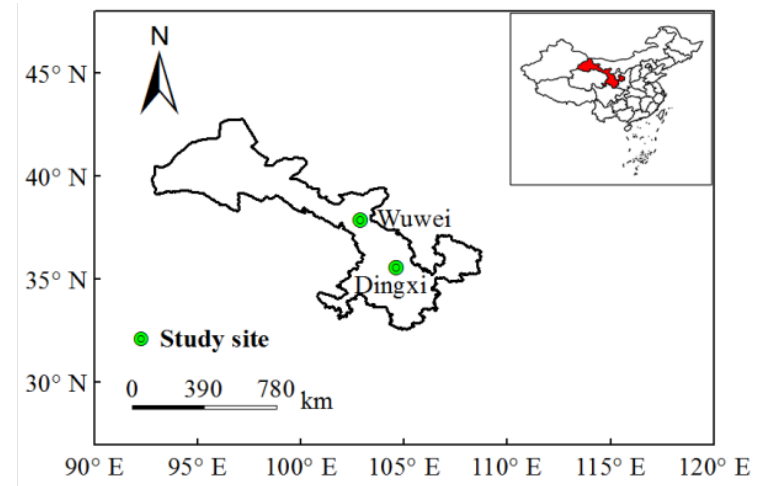
Figure 1. Location of the study area.